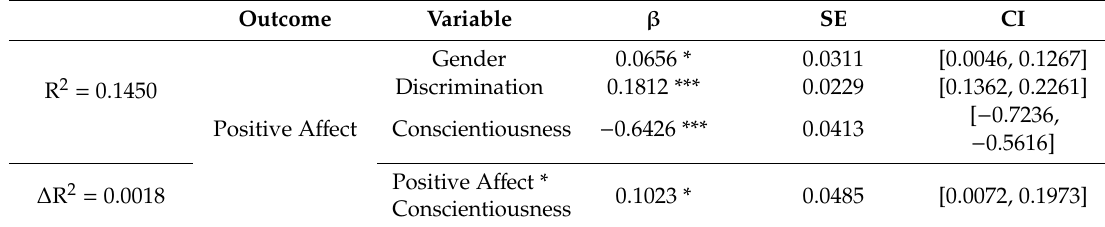
Table 5. Regression of positive a ff ect on discrimination, conscientiousness, and their interaction.